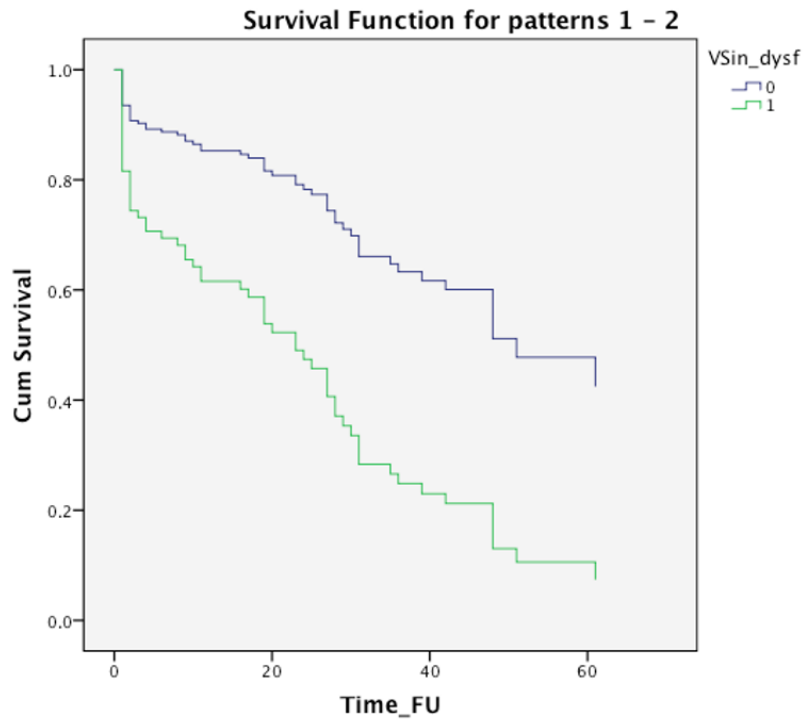
Figure 4. Kaplan-Meier survival curves for VAs recurrence according to Left ventricular Ejection